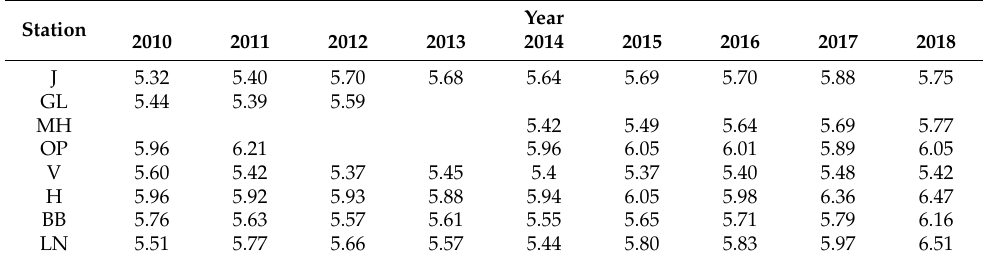
Table 4. Mean pH values at year station across the selected years 2010–2018. Empty cells in the table are due to unavailable